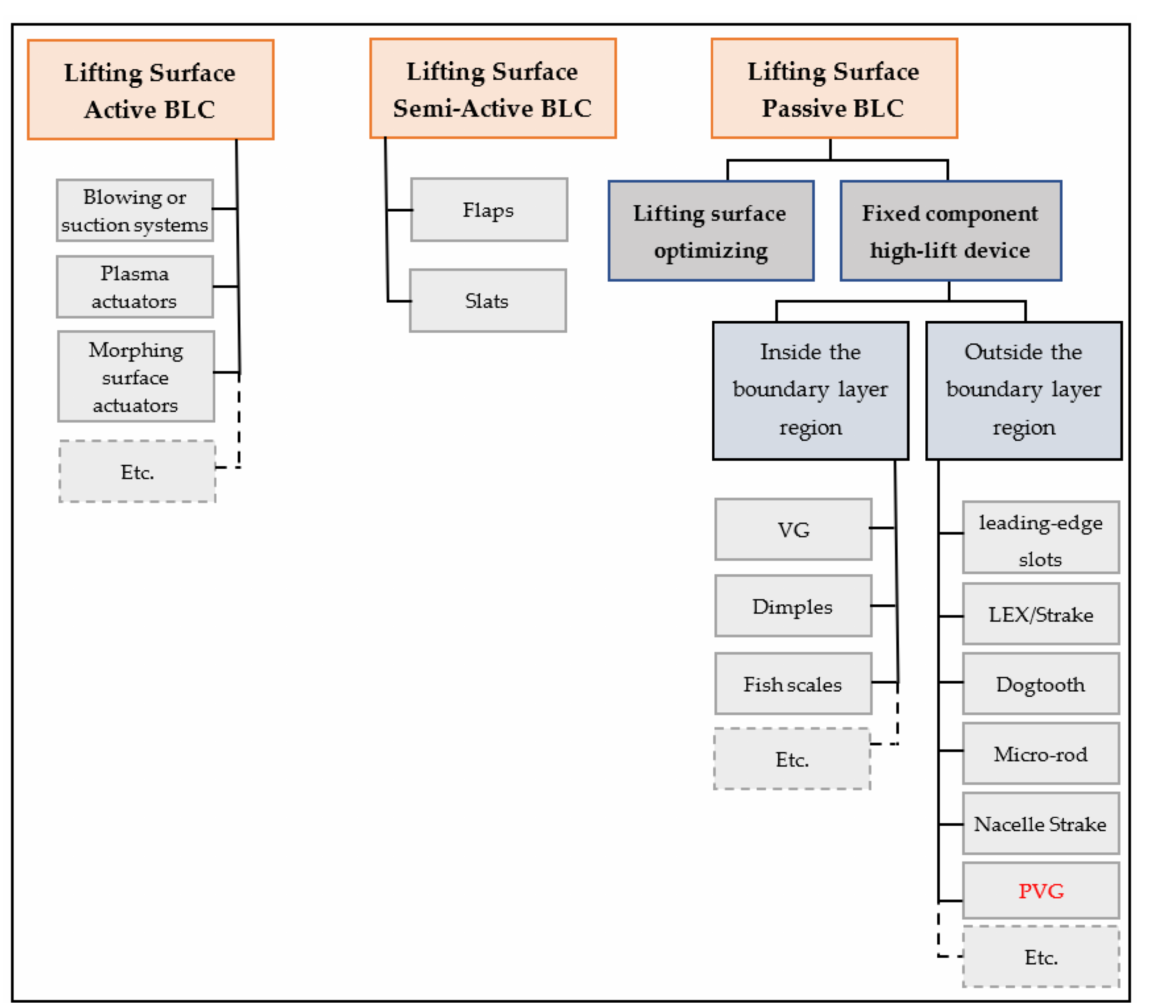
Figure 1. The categories of lifting surface